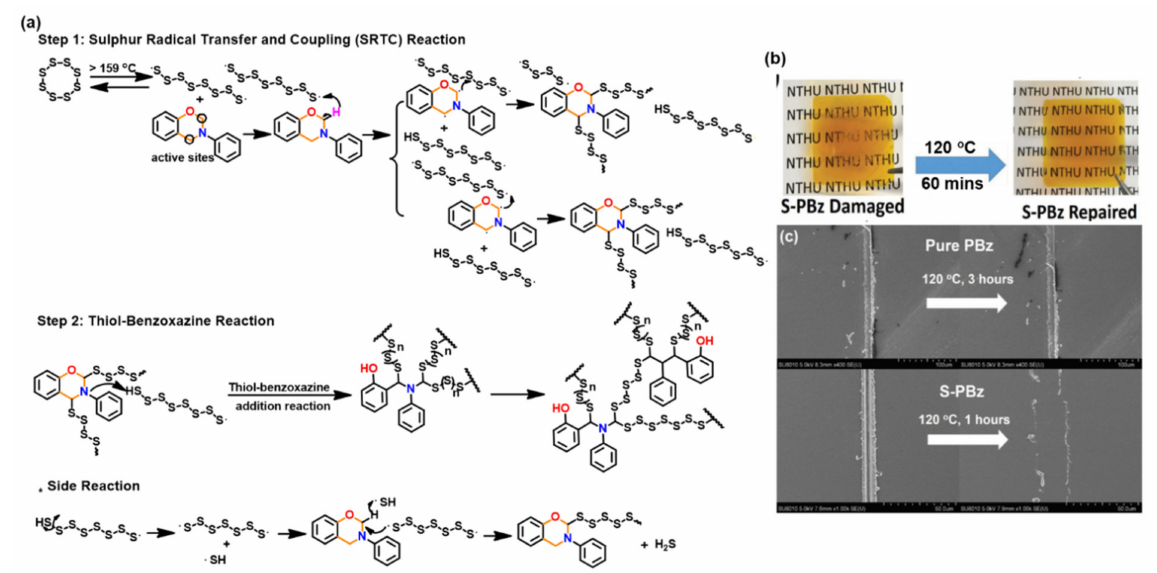
Figure 44. ( a ) Reaction mechanism between S 8 and benzoxazine through the SRTC reaction and thiol–benzoxazine addition reaction, ( b ) optical images and ( c ) SEM micrographs showing the thermally induced repairing behavior of resins [288]. Copyright 2018. Reproduced with permission from WILEY-VCH Verlag GmbH & Co. KGaA, Weinheim,